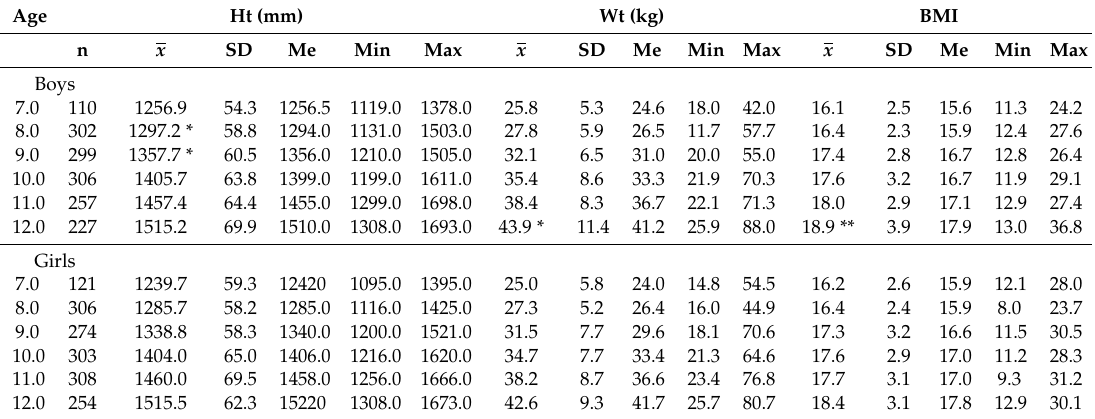
Table 1. Statistical characteristics of height (Ht), weight (Wt) and body mass index (BMI) in rural boys and girls.